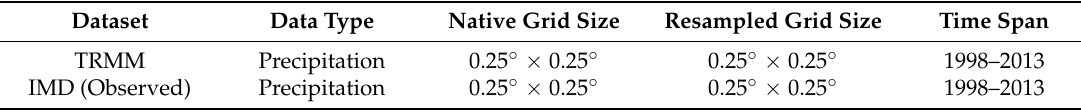
Table 1. Details of the datasets used in this